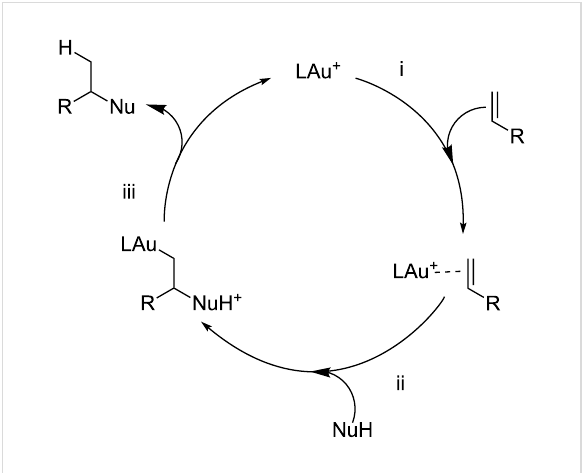
Figure 1: Elementary steps in the gold-catalyzed nucleophilic addition to olefins.